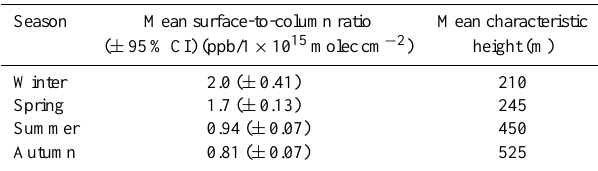
Table 3. Mean surface-to-column ratio ( ± 95% confidence interval) and characteristic height, by season.